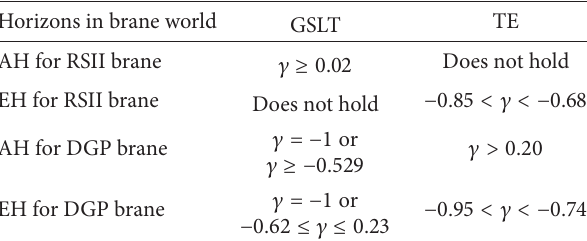
Table2:ConditionsforGSLTandTEtoholdwhenUniverseisfilled with Modified Chaplygin